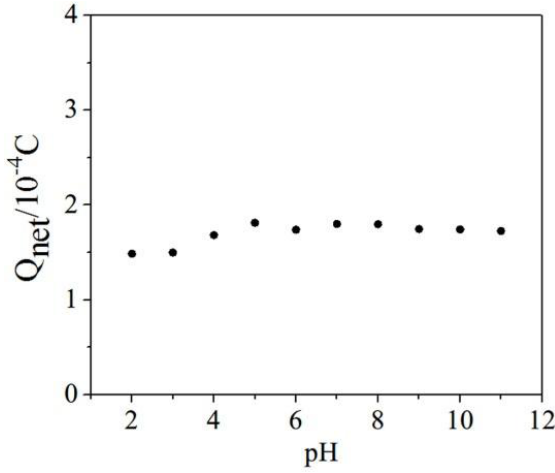
Figure 8. Effect of pH on Q